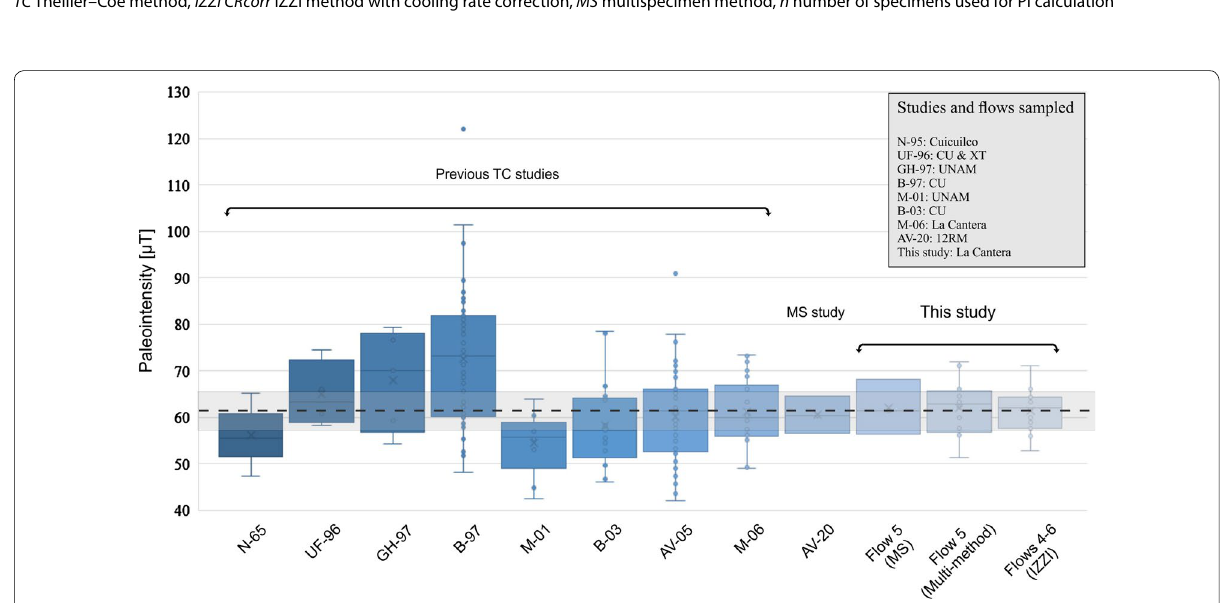
TC Thellier–Coe method, IZZI CRcorr IZZI method with cooling rate correction, MS multispecimen method, n number of specimens used for PI calculation